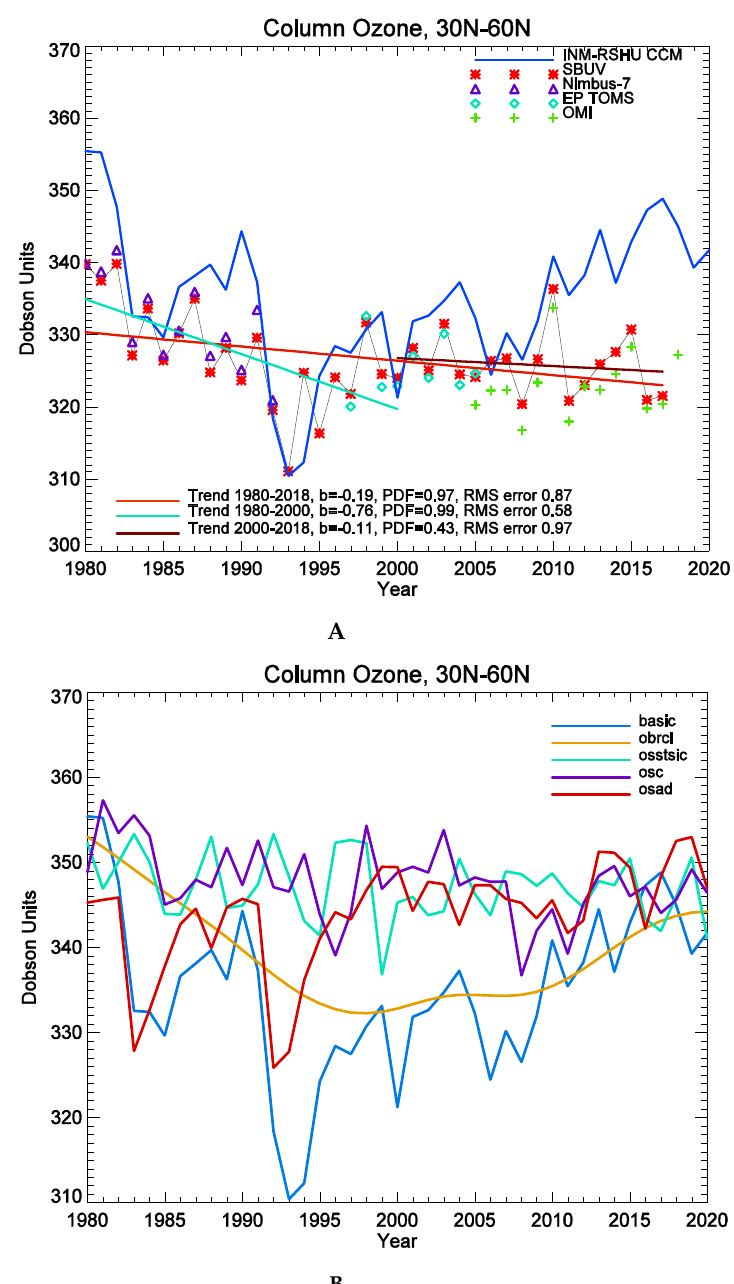
Figure 3. Interannual variability of column ozone in the northern mid-latitudes: ( A ) Results of satellite measurements (solar backscattering ultraviolet (SBUV), Nimbus-7 Total Ozone Mapping Spectrometer (TOMS), Earth Probe (EP) TOMS, and the Ozone Monitoring Instrument (OMI)) and numerical modeling (chemistry—climate model of the Institute of Numerical Mathematics and the Russian State Hydrometeorological University) with an assessment of trends (b—coefficient of linear regression) and their significance (PDF—probability density function, and RMS—root mean square error); ( B ) results of numerical modeling under scenarios with a separate action of influencing factors: basic—all factors’ interannual variabilities are taken into account, obrcl—only the surface emissions of bromine and chlorine-containing gases’ interannual variability is taken into account, osstsic—only sea surface temperature and sea ice coverage interannual variabilities are taken into account, osc—only solar radiation’s interannual variability is taken into account, osad—only sulfate aerosol density’s interannual variability is taken into account.